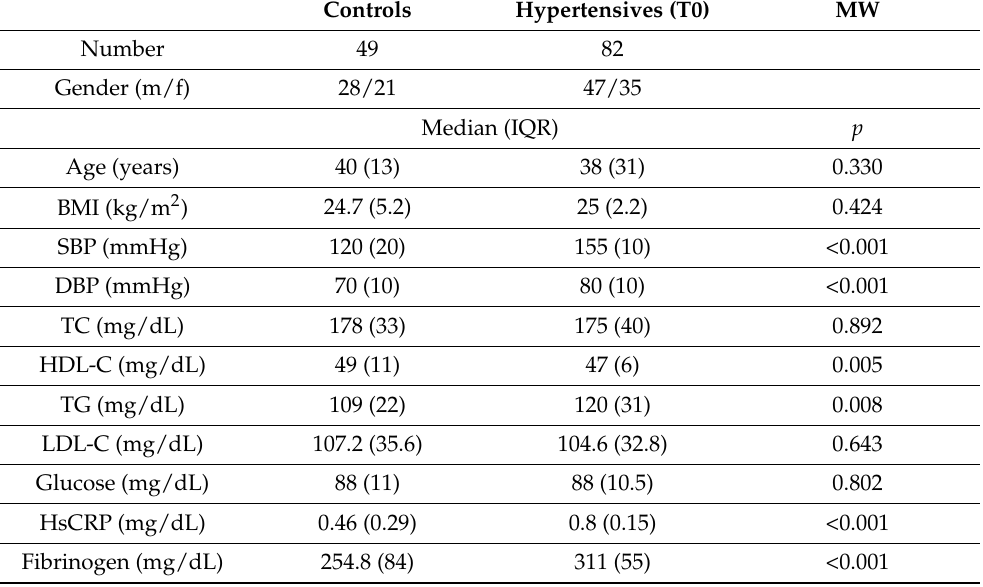
Table 1. Characteristics of study population (hypertensive patients and